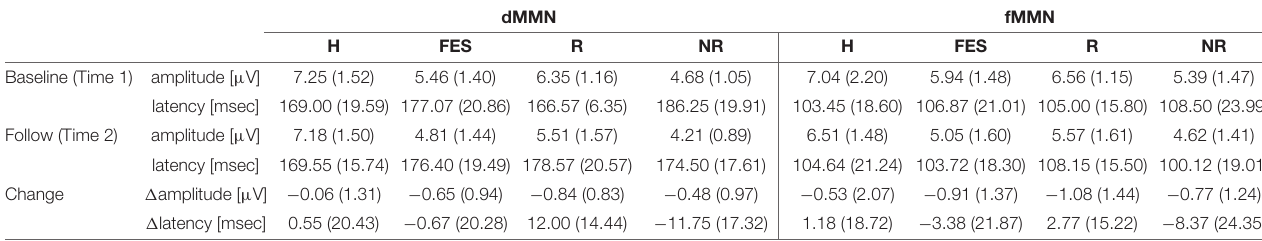
TABLE 3 | MMN parameters.